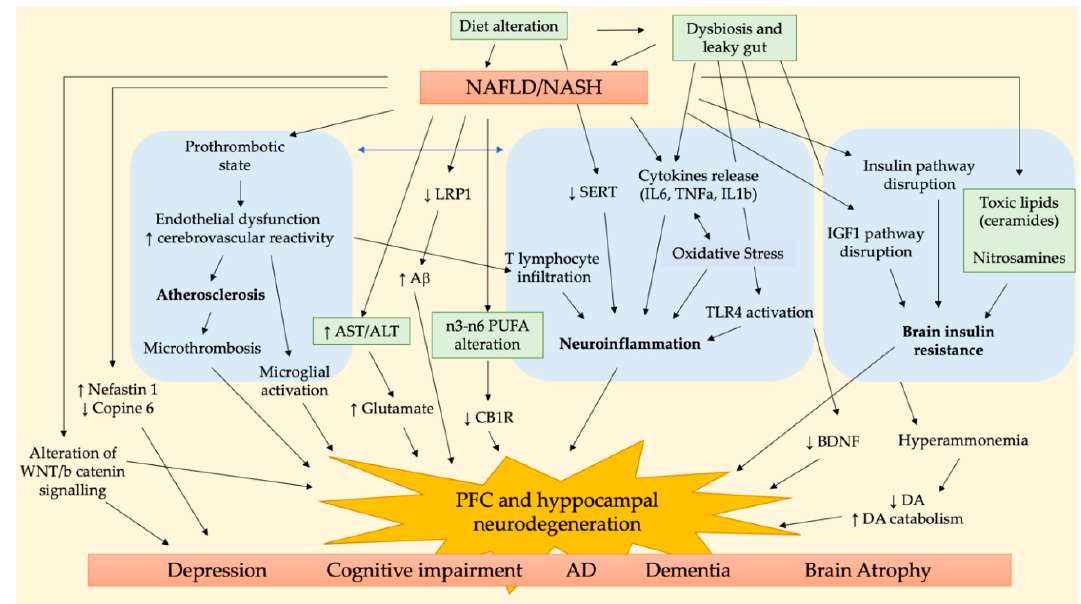
Figure 1. Main pathophysiological pathways involved in NAFLD / NASH and cognitive